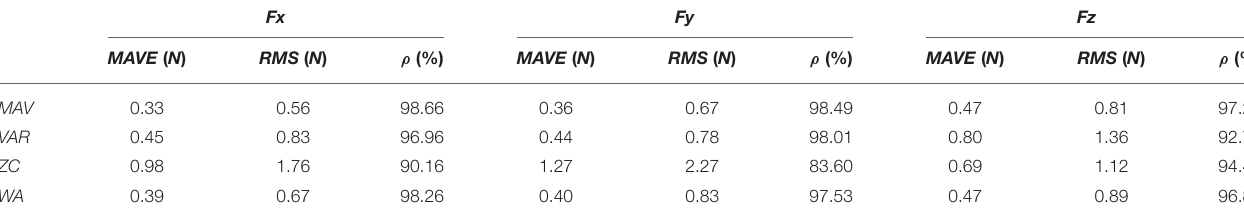
TABLE 10 | The average results of the 3D force estimation experiments across all the subjects.